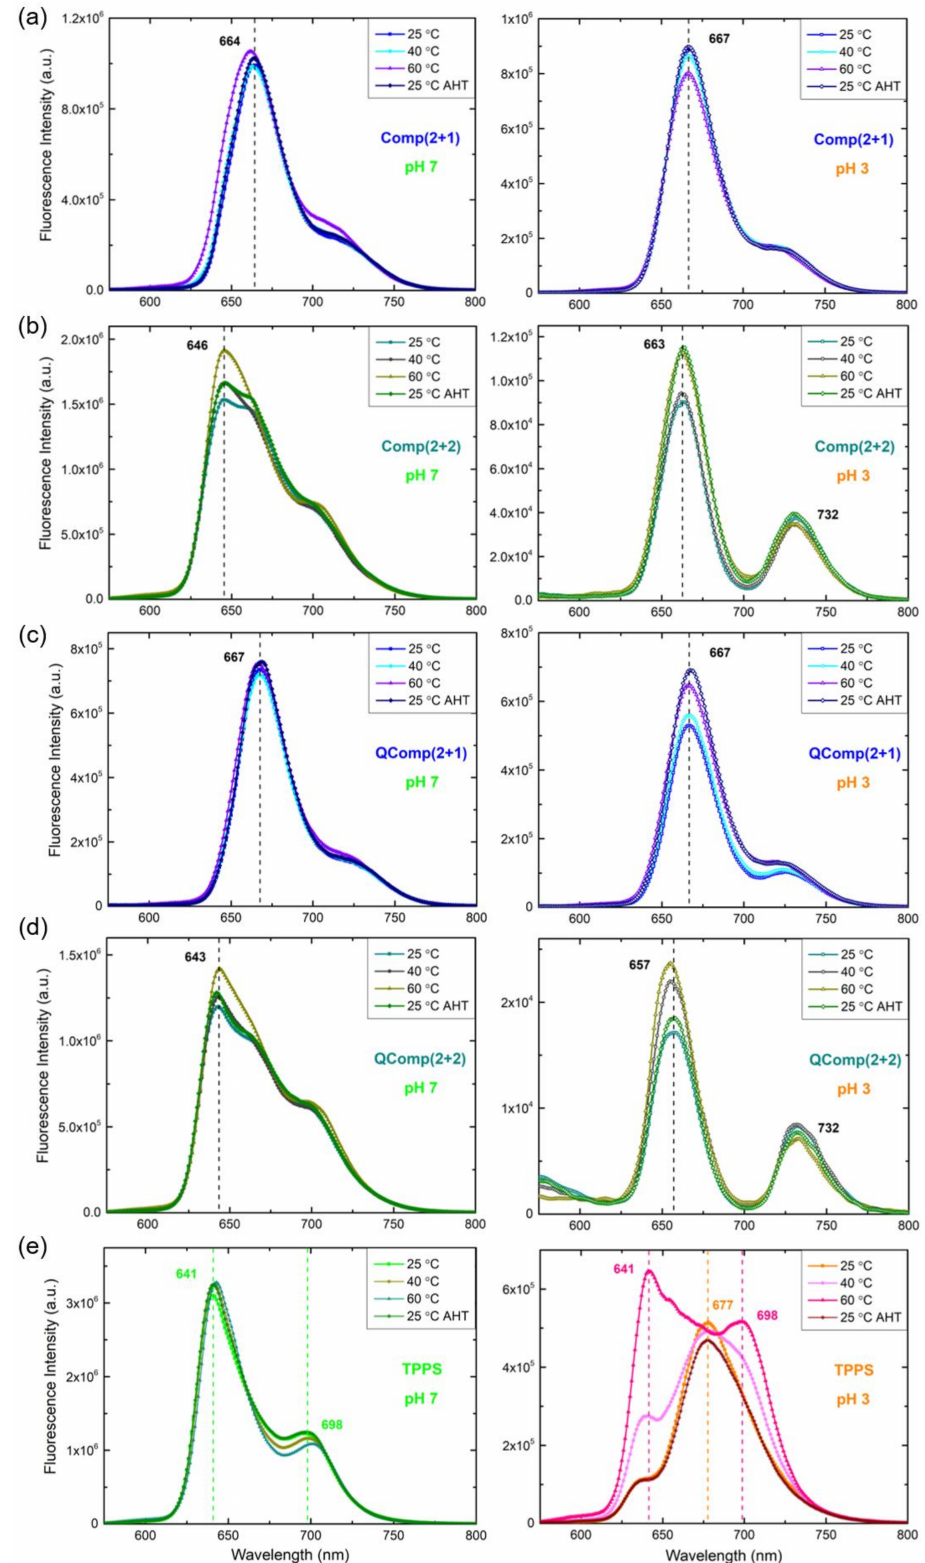
Figure 9. Fluorescence spectra of the complex solutions ( a , c ) (Q)Comp (2 + 1) and ( b , d ) (Q)Comp (2 + 2) of the (Q)DHBC/TPPS systems at pH 7 (left) and 3 (right) at different temperatures: 25, 40, 60 °C, and 25 °C after heat treatment (AHT). ( e ) The corresponding spectra of neat TPPS for